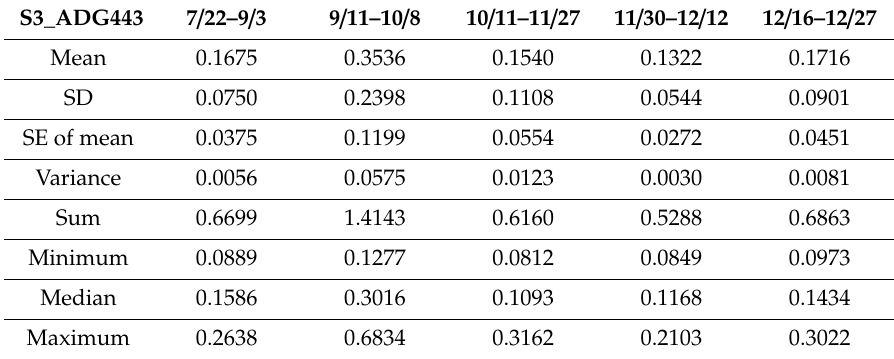
Table 1. Statistics for five time periods on ADG443_NN product from Sentinel